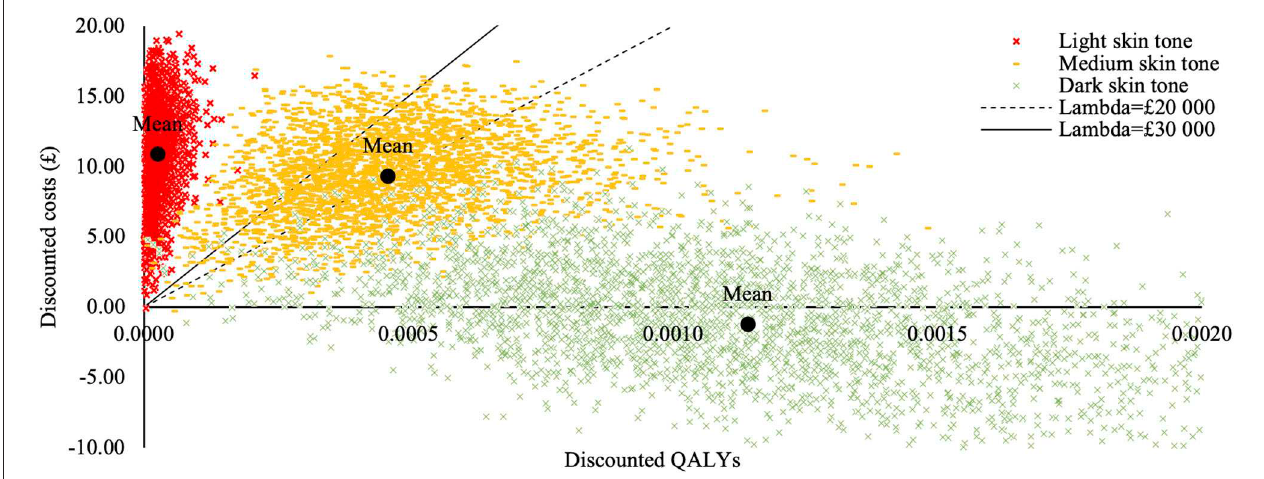
FIGURE 2 | Cost-effectiveness acceptability plane for the homogenous population subgroups (base-case analysis). Cost effectiveness acceptability plane was generated in the probabilistic sensitivity analysis and illustrates differences in costs and treatment outcomes between current and alternative practices, taking parameter uncertainty into account. Each dot represents a random probabilistic estimate of the incremental costs and quality adjusted life years (QALYs). Cost-effectiveness probabilities presented in the base case analysis are calculated as a proportion of these samples below the threshold values. The mean price per QALY value for the subgroup consisting of children with dark skin tone is below the “x” axis meaning the intervention is cheaper than the current practice; the price per QALY estimates for the subgroup consisting of children with medium skin tone are scattered in the upper quadrant around the threshold lines, illustrating uncertainty of intervention’s cost-effectiveness. The price per QALY estimates for the subgroup consisting of children with light skin tones are concentrated along the “y” axis, well above budget threshold lines, illustrating minimal health gains and considerably higher